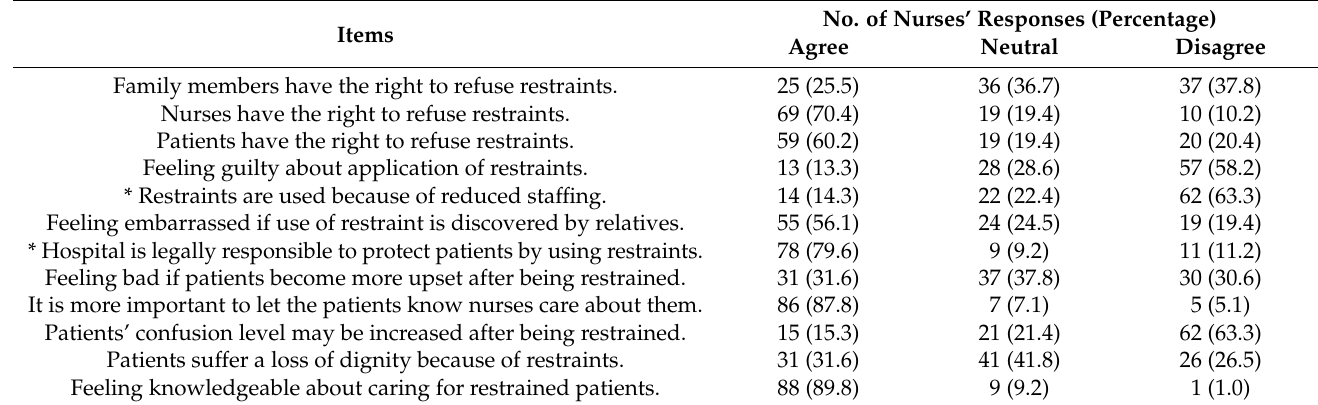
No. of Nurses’ Responses (Percentage) Agree Neutral Disagree